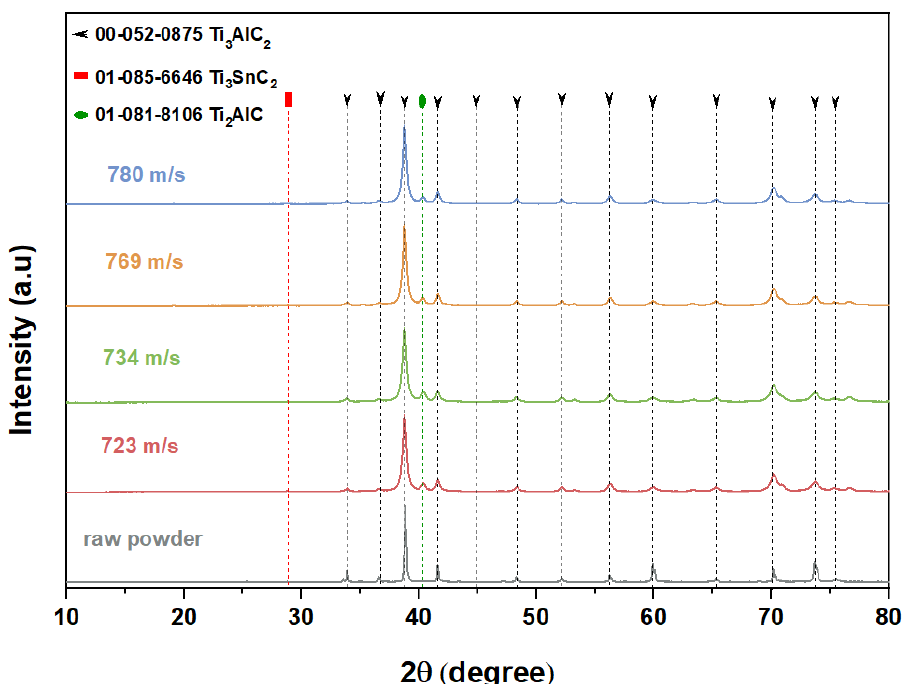
Figure 13. XRD patterns of the Ti 3 AlC 2 feedstock powder and coatings were obtained at different particle velocities in the CS process.